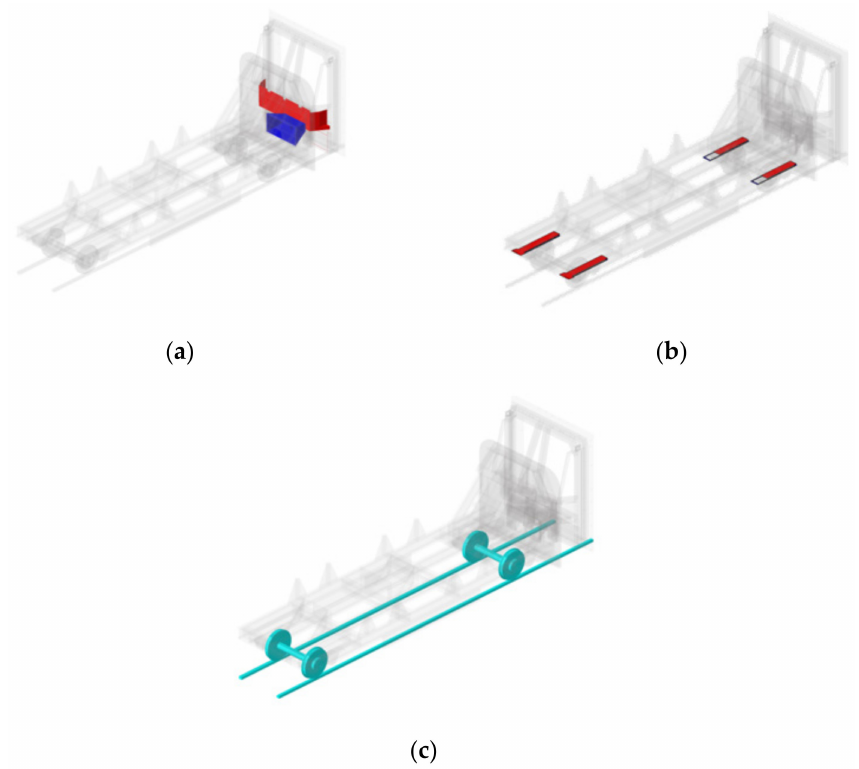
Figure 7. Surface-to-surface contact algorithm: ( a ) impact ram and cab car front-end; ( b ) wheel and test trolley; ( c ) wheel and rail.